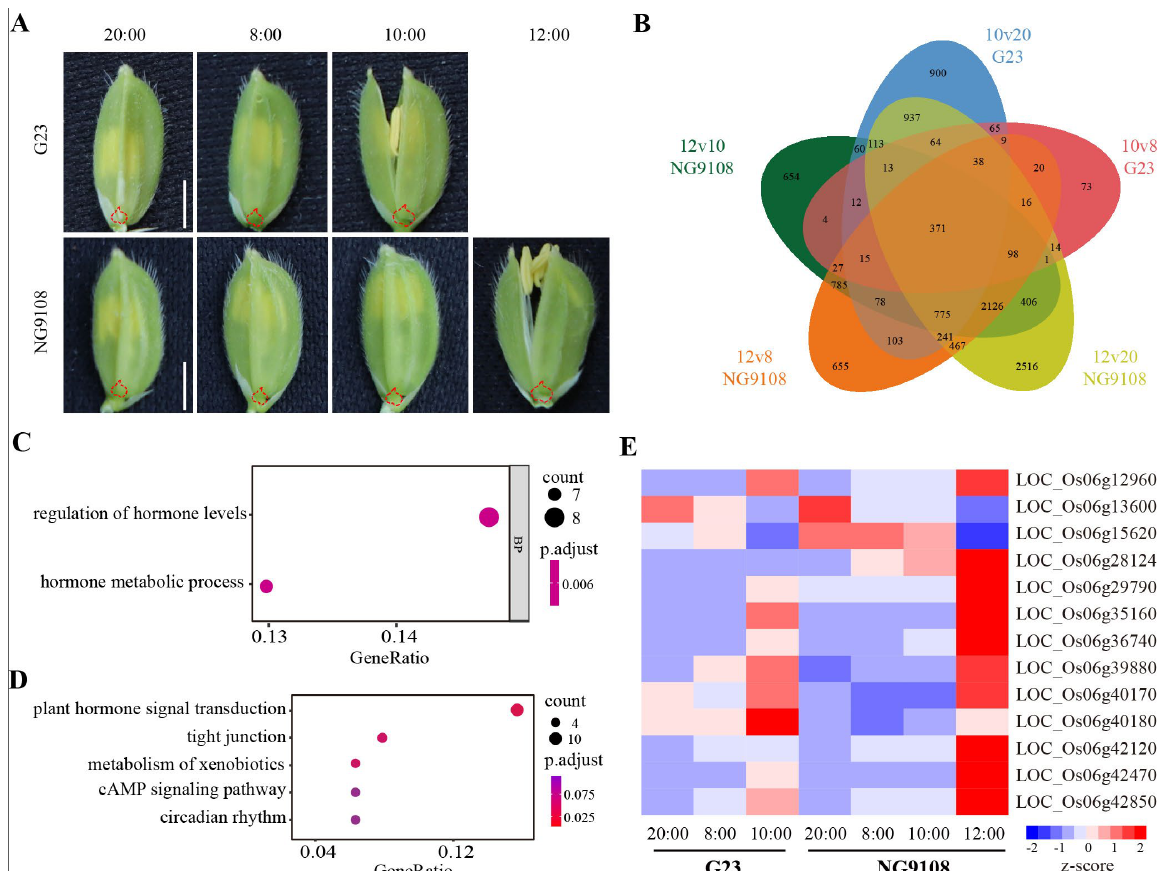
Figure 4. RNA-seq analysis of lodicules to screen candidates regulating early FOT in G23. ( A ) Schematic diagrams of the spikelet opening states at various time points for lodicule collection and RNA extraction. The red dotted lines showed the positions and possible sizes of lodicules inside lemma and palea. ( B ) Venn diagram of overlapped DEGs in lodicules at various time points between G23 and NG9108. ( C ) GO analysis of potential 371 FOT-regulating genes. The circle size represents the gene number, while the circle color represents the value of p.adjust. ( D ) KEGG analysis of 371 potential FOT-regulating genes. Circle size represents the gene number, while circle color represents the value of p.adjust. ( E ) Heat map of 13 potential candidate genes within qFOT6 region. Changes in expression levels are displayed from blue (down-regulated) to red (up-regulated). The numbers